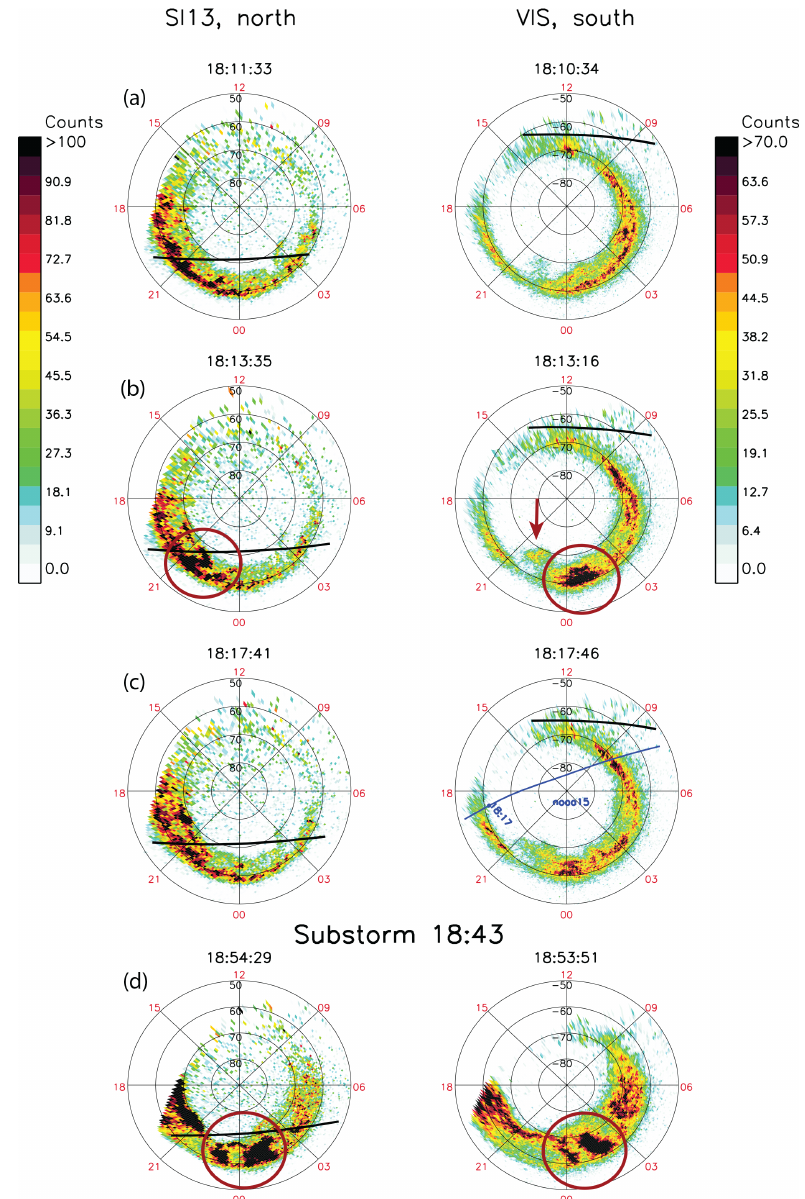
Figure 4. 17 August 2001: (a–d) pairs of simultaneous (as close as possible) auroral images from Northern (left) and Southern (right) Hemispheres. All panels show SI13 and VIS. Black lines indicate the terminator at 90 ◦ solar zenith angle. Features we claim are conjugate are marked with red circles. Blue line in panel (c) is the trajectory of the NOAA 15 pass in the Southern Hemisphere. Time of the second substorm is also